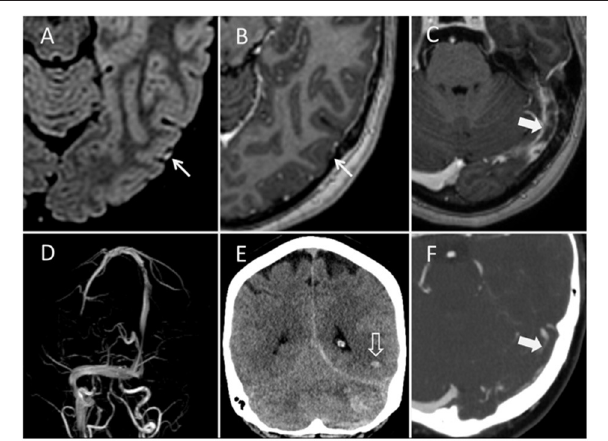
FIGURE 3 | MRI, CT, and CT venography of patient 3. Thrombosis in a cortical vein (thin arrows) is possible to spot with high signal intensity on axial FLAIR (A) and filling defect on contrast enhanced axial T1-MPRAGE (B) . Corresponding temporo-occipital hemorrhage (open arrow), cerebellar hemorrhage and high attenuation from thrombus in transverse and sigmoid sinuses can be seen on coronal CT (E) . 3D phase-contrast MR venography demonstrates loss of flow signal in left transverse and sigmoid sinus (D) . The thrombus in sigmoid sinus (thick arrows) is also evident on contrast enhanced axial T1-MPRAGE (C) and CT venography (F)